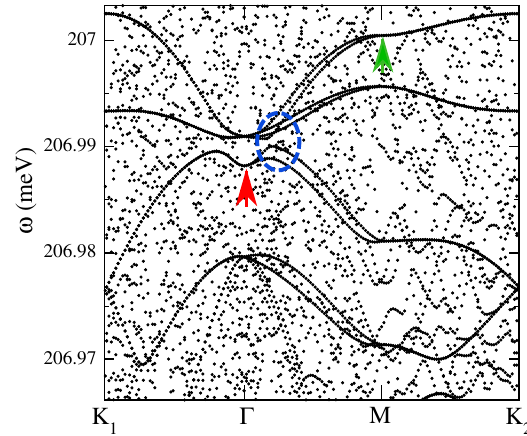
FIG. 5. Enlargement of the optical region of the phonon spectrum of the fully relaxed TBLG at θ ¼ 1 . 08 . Among many scattered energy levels of highly dispersive branches (not resolved in this narrow energy window), a set of 10 narrow continuous branches stands out (no line drawn through data points, which just fall next to one another). The degeneracy of these modes is twice that expected by D 6 space symmetry, similar in this to electronic bands. The twofold degenerate mode with the highest overlap with the deformation η ð r Þ , drawn in Fig. 6, is marked by a red arrow, while the mode at M used in Sec. VI is marked by a green arrow. The avoided crossing which occurs close to Γ is encircled by a blue dashed